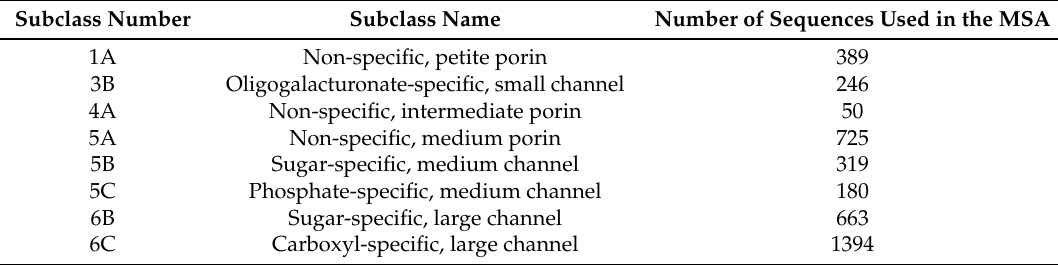
Table 5. Number of sequences used in MSA (multiple sequence alignment analyses). The number of sequences used in the final MSA that was generated for each class is listed together with the class number and name. The lacking classes (and subclasses) are reserved for future structures and highlighted with a question mark.